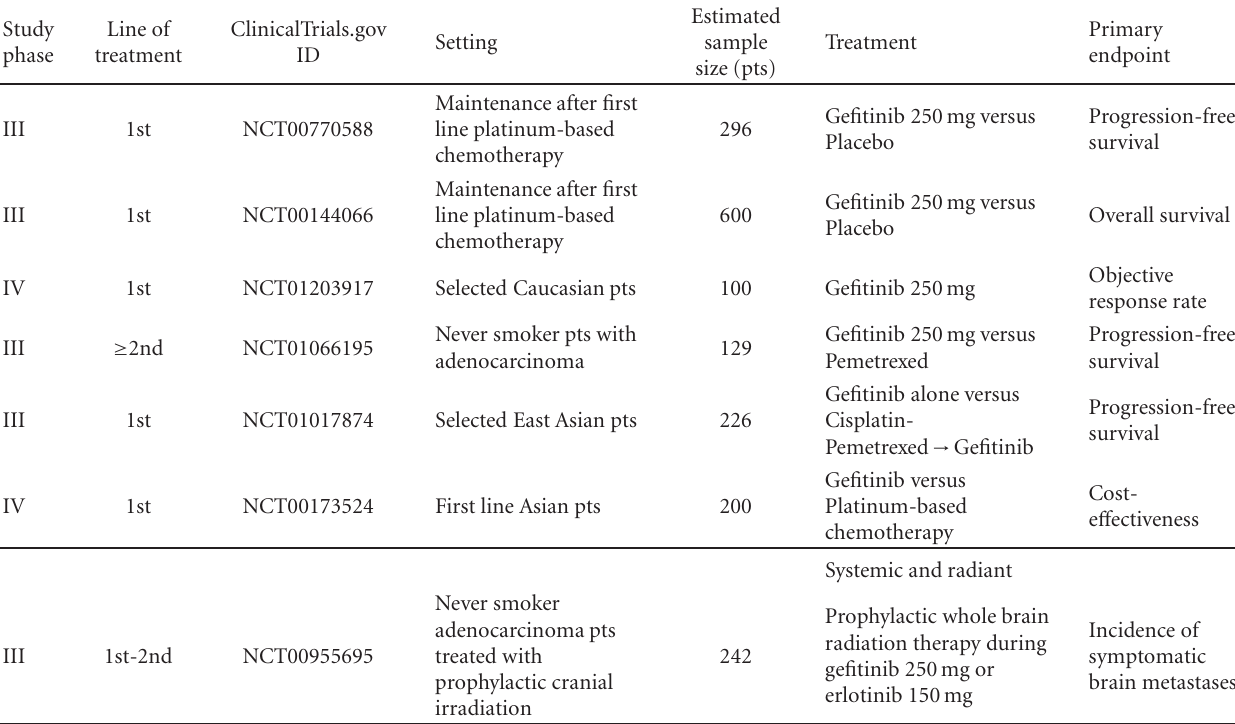
Table 5: Ongoing phase III/IV studies in